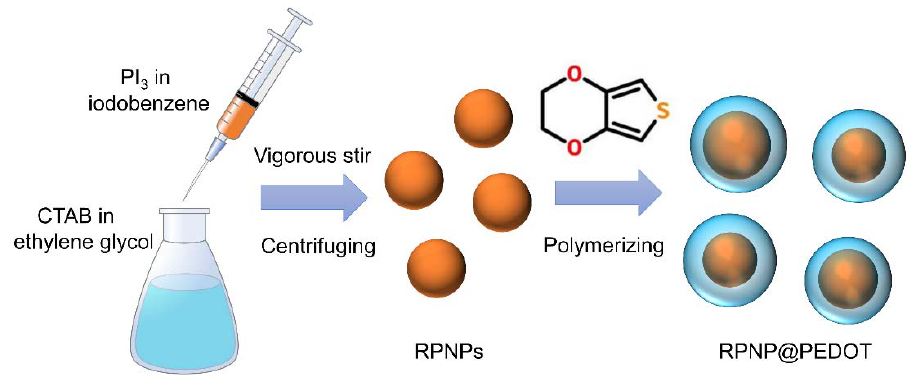
Figure 1. Schematic illustration of synthesis procedure of RPNPs and RPNP@PEDOT.